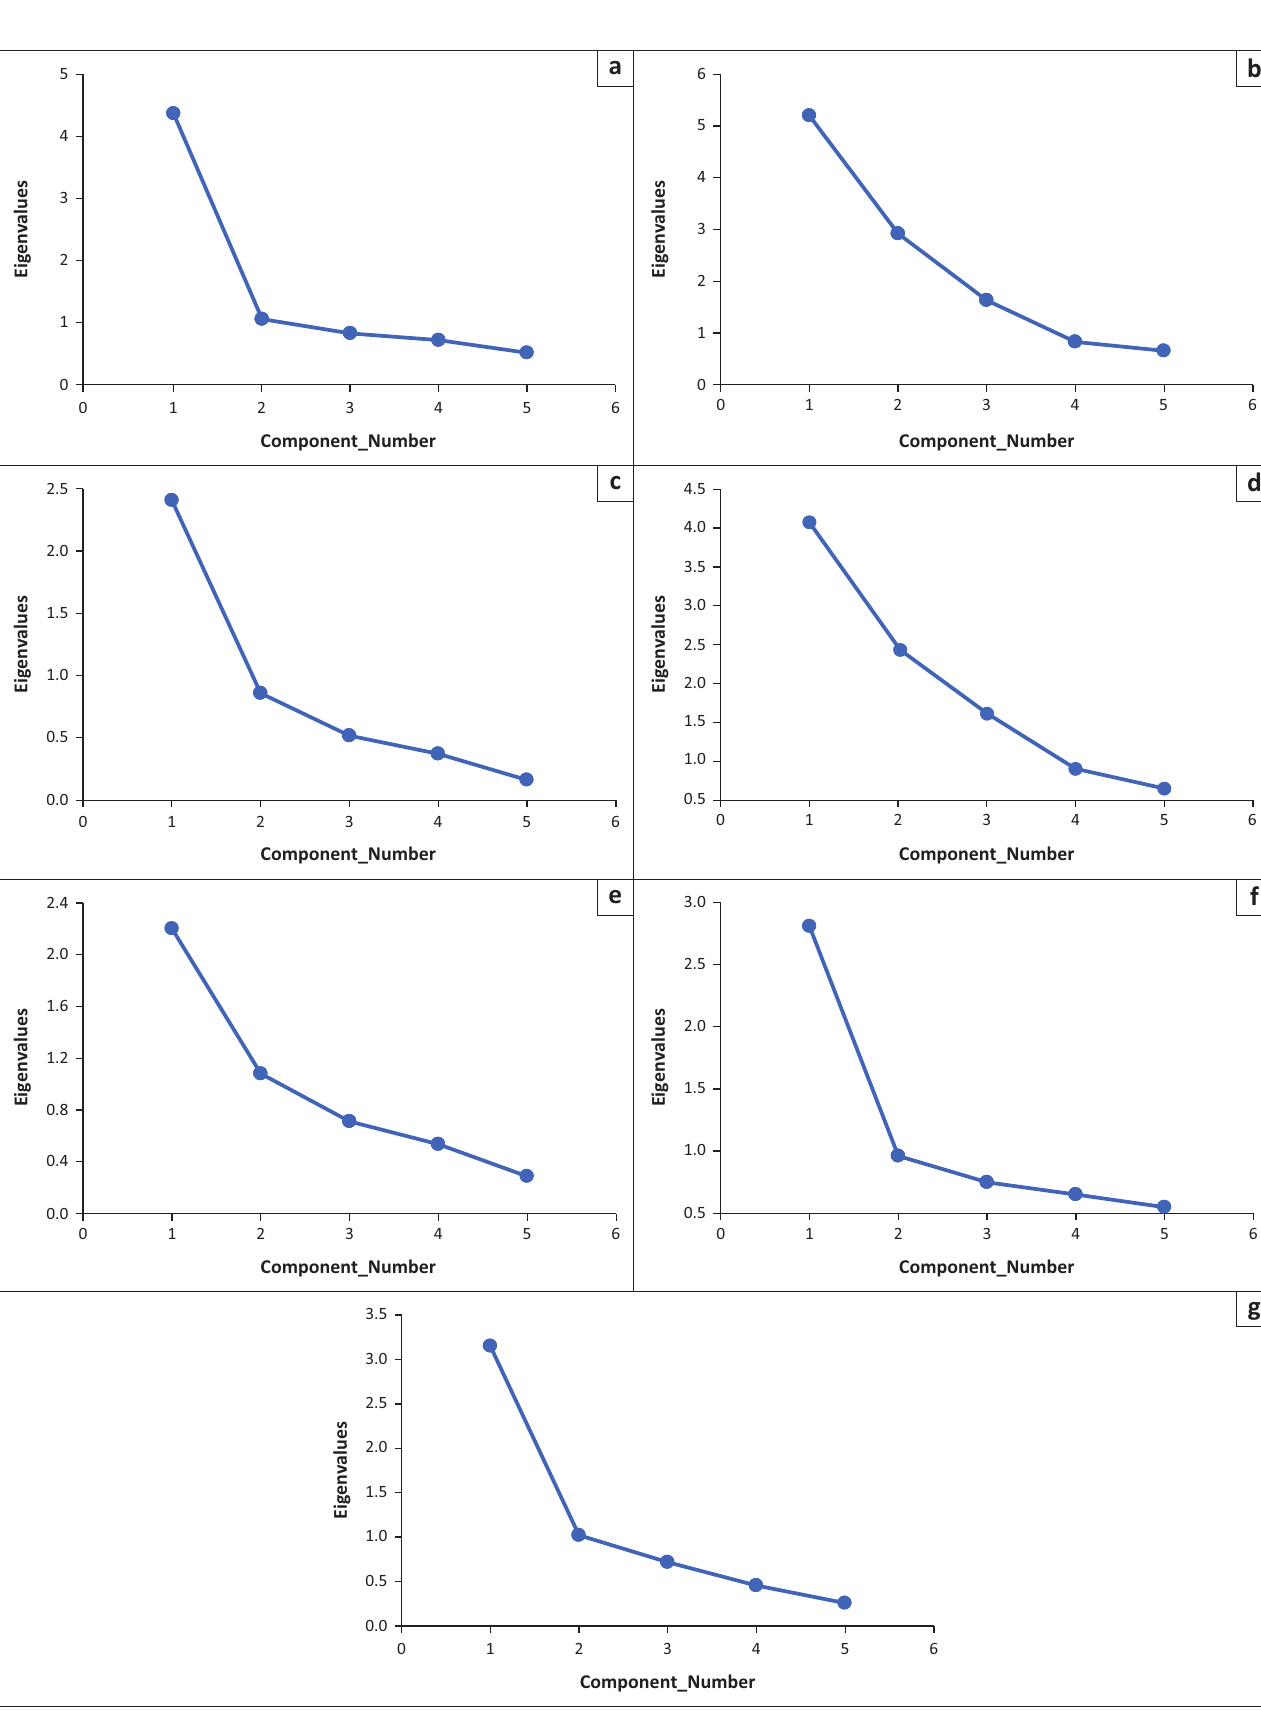
FIGURE 1: Screen plot of the eigenvalues of each respective section. (a) South African credit conditions, (b) South African interest rate conditions, (c) South African house prices, (d) South African equity markets, (e) financial confidence indicators, (f) foreign financial positions, (g) bank balance sheet